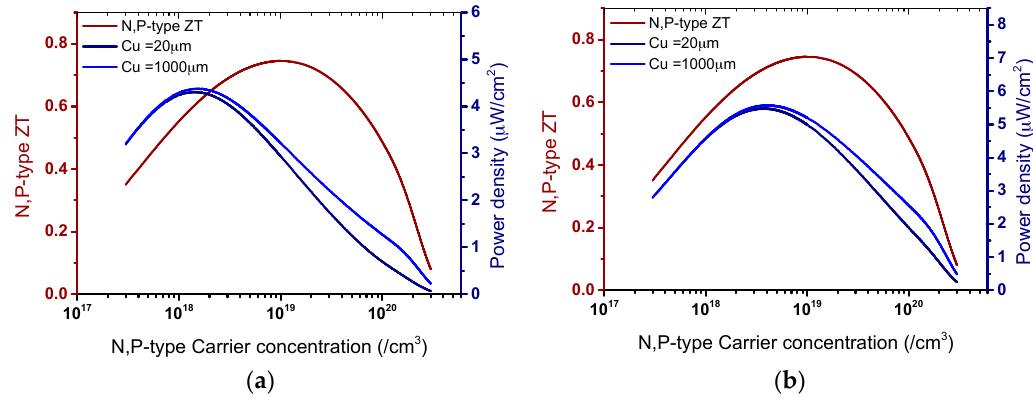
Figure 6. The power density distribution of ( a ) material D and ( b ) material A based TEG with variation of the copper thickness